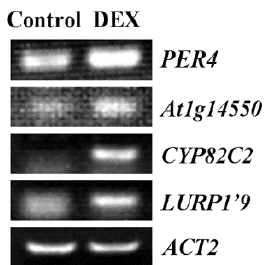
Figure 7. RT-PCR validation of some different expressed genes. Four genes up-regulated at least 2.0-fold in 35S:MYB71-GR transgenic plant treated with DEX were selected and examined by RT-PCR. The expression of ACT2 was used as a